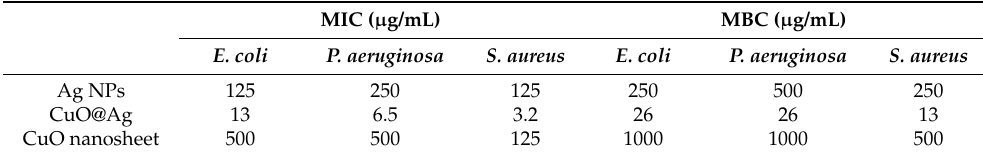
Table 1. MIC and MBC numerical values of Ag, CuO@Ag nanocomposites, and CuO nanosheets. MIC ( µ g/mL) MBC ( µ g/mL) E.